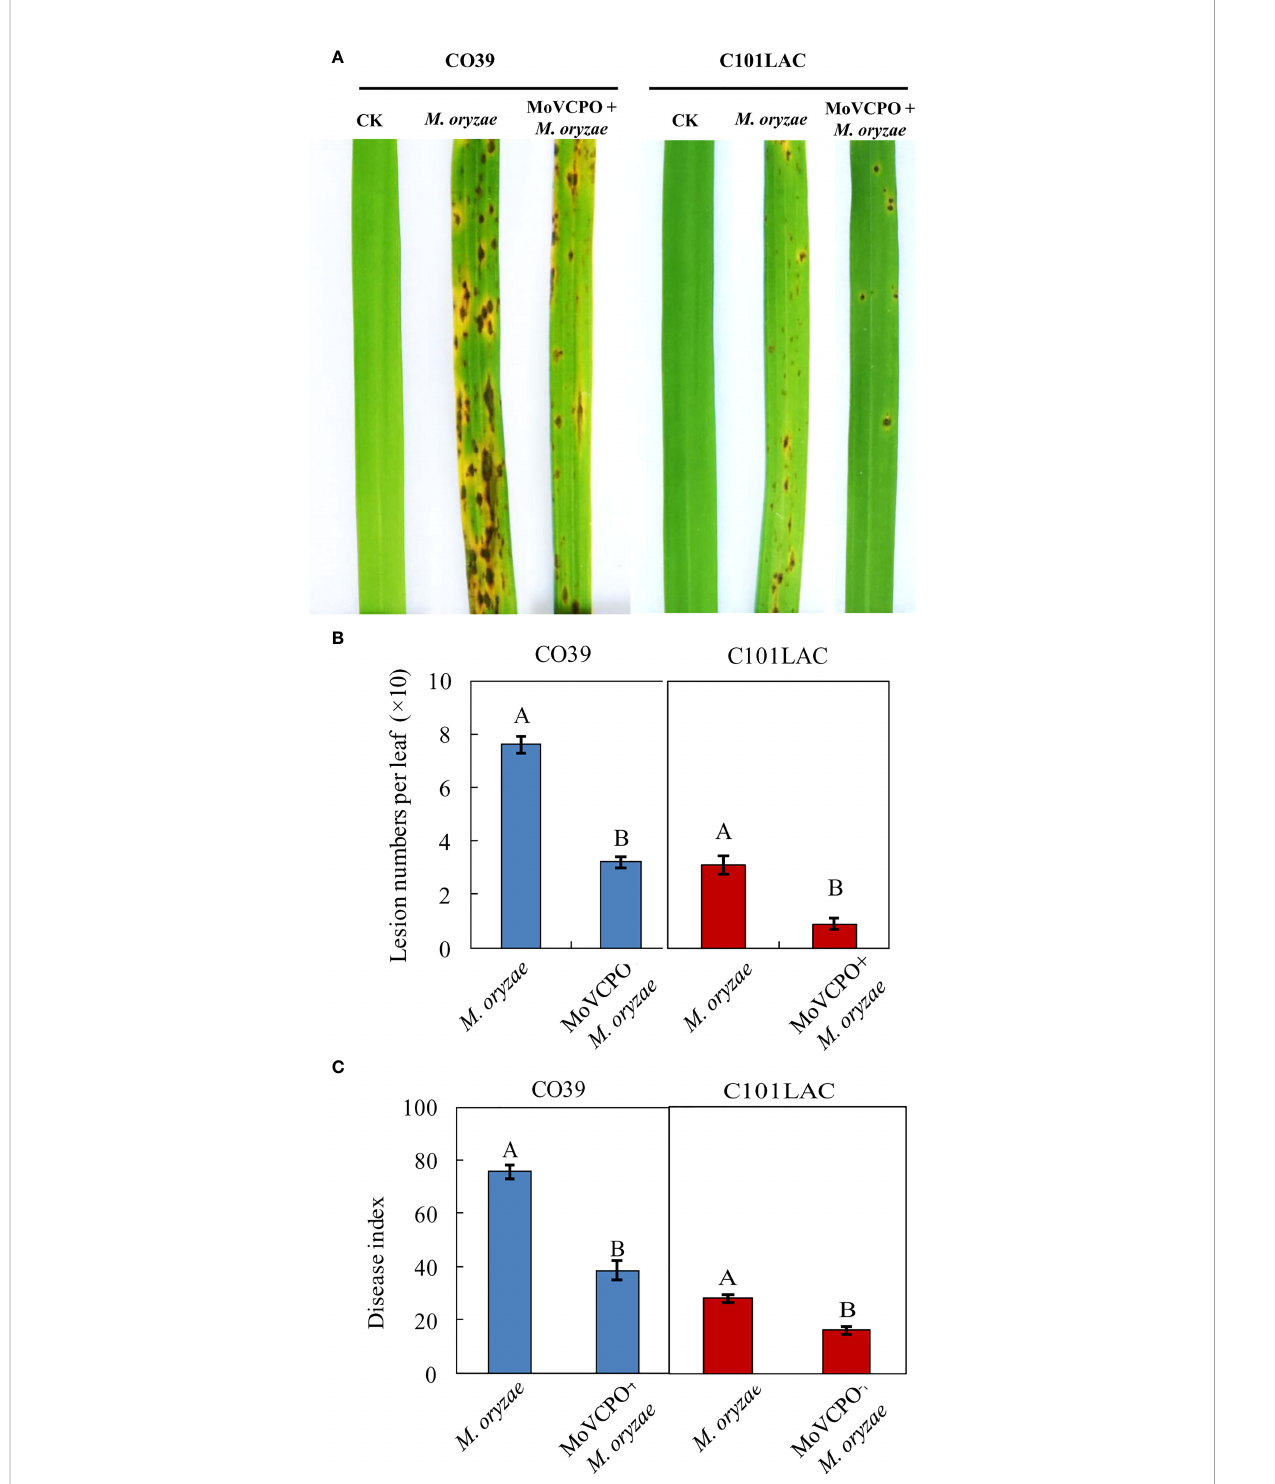
FIGURE 3 MoVcpo enhances rice resistance against M. oryzae infection. (A) Disease symptoms. Rice seedlings were sprayed with 50 m g/mL MoVcpo solution or TH buffer as a control at 2 d before inoculation with M. oryzae . Disease severity was scored at 7 d post inoculation with conidia and the leaves of representative plants were photographed. (B) Disease index. (C) Mean number of lesions per leaf. Data bars are the means (± standard error) of 90 replicates from three independently biological experiments. The letters above the bars are signi fi cantly different at 0.05 level. All experiments were repeated for three